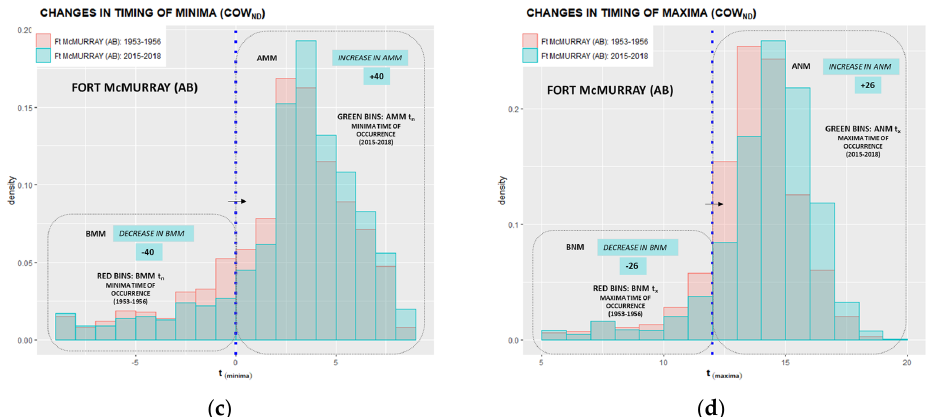
Figure A14. Northwestern Forest climate region: Cold Lake (AB) and Fort McMurray (AB). Time evolution of the Diurnal Extrema Timing (DET) histograms at Cold Lake ( a , b ), and Fort McMurray ( c , d ) stations. Migration of the Before Midnight Minima (BMM) to After Midnight Minima (AMM) and migration of the Before Noon Maxima (BNM) to After Noon Maxima (ANM) between four-year averages at the beginning (1953–1956) and ending (2015–2018) of data ranges. The blue dotted line represents midnight delineation ( left ) and noon delineation ( right ).